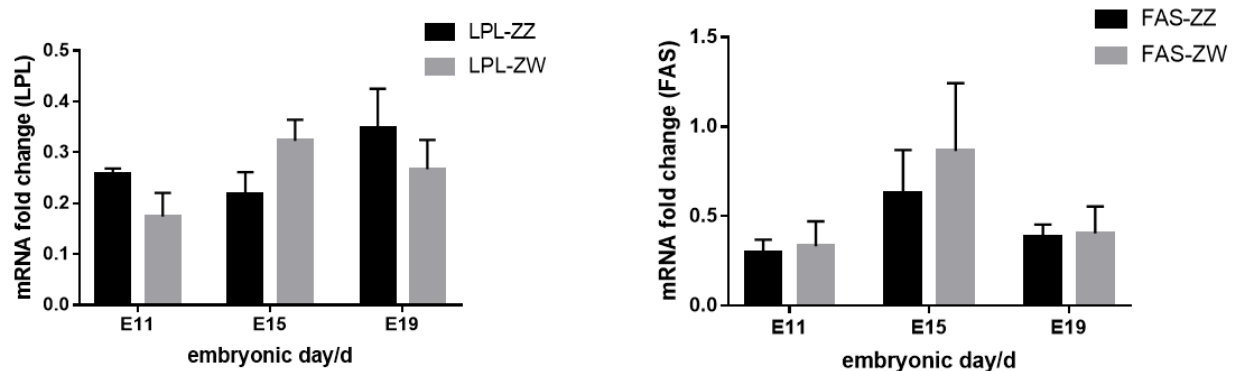
Figure 6. The developmental change of lipid-related gene expression in chicken embryo livers with different sexes. ZZ in the picture represents male chicken embryos, and ZW represents female chicken embryos.